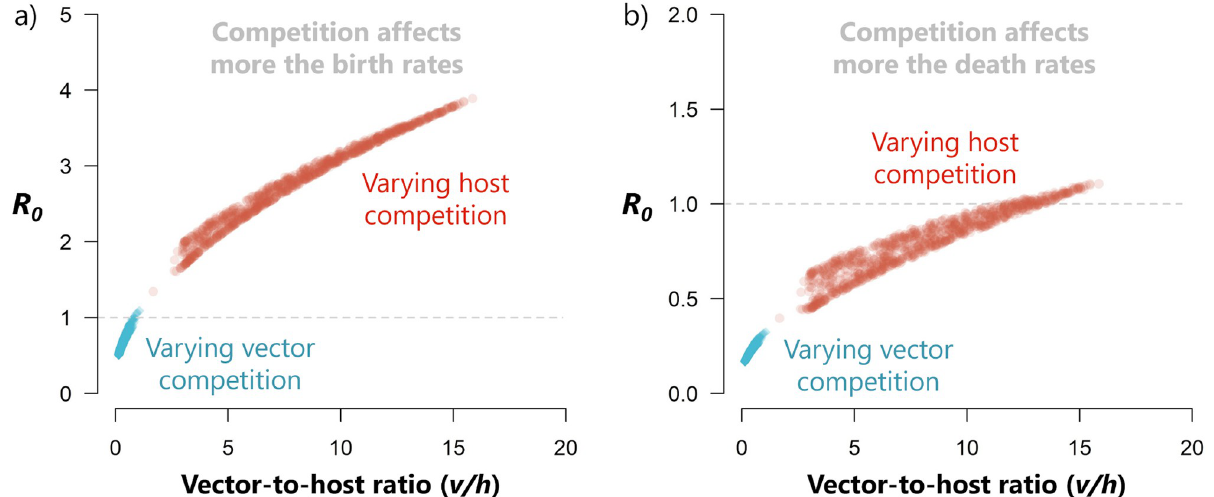
Fig 4. Relationship between the vector-to-host ratio, v / h , and R 0 . The different values for v / h are obtained by varying only the competition coefficients in vectors (blue diamonds) and in hosts (red circles). Two scenarios are considered: a) most competition acts on the birth rates of the affected species ( d = 0.1, d = 0.05) or b) on the death rates ( d = 0.9, d = 0.85). ii ij ii ij